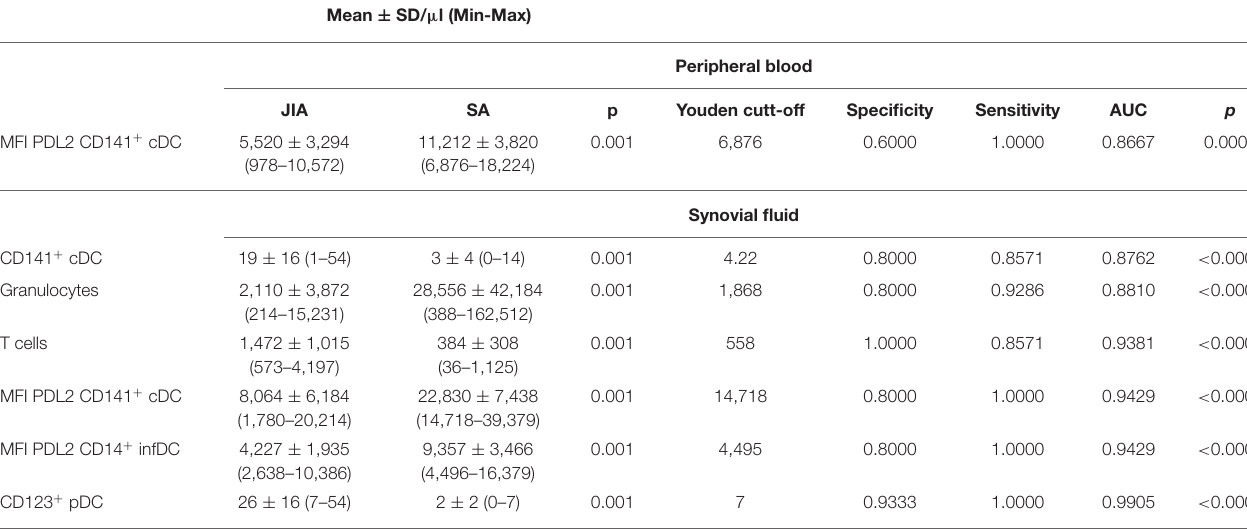
TABLE 4 | Parameters highly significantly different between diseases after age-adjustment, with AUC value > 0.85 in the ROC curve